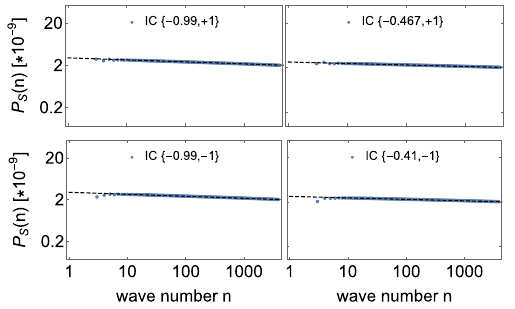
Fig. 5 Primordial scalar power spectrum for different set of back- groundinitialconditions,foraquadraticpotential,andwithfluctuations initiated after the bounce (blue dots). The standard power law is repre- sented as a dashed black line. The IC for the background are: top left {− 0 . 99 , + 1 } , top right {− 0 . 467 , + 1 } , bottom left {− 0 . 99 , − 1 } , bottom right {− 0 . 41 , − 1 }